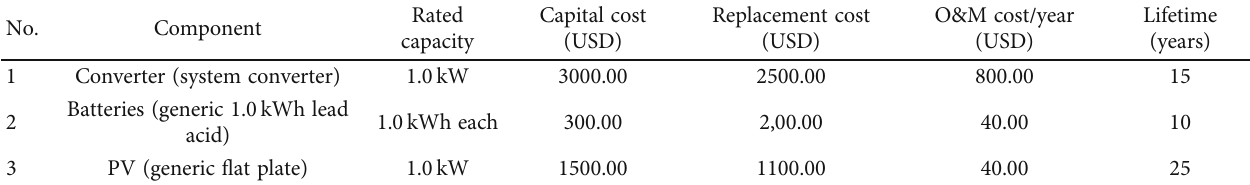
Table 3: System elements and their costs for an islanded PV of an individual